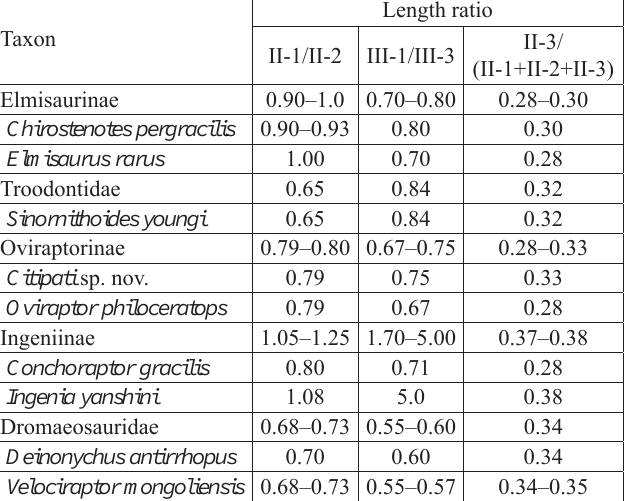
Table 3. Phalangeal proportions in maniraptoran manus.